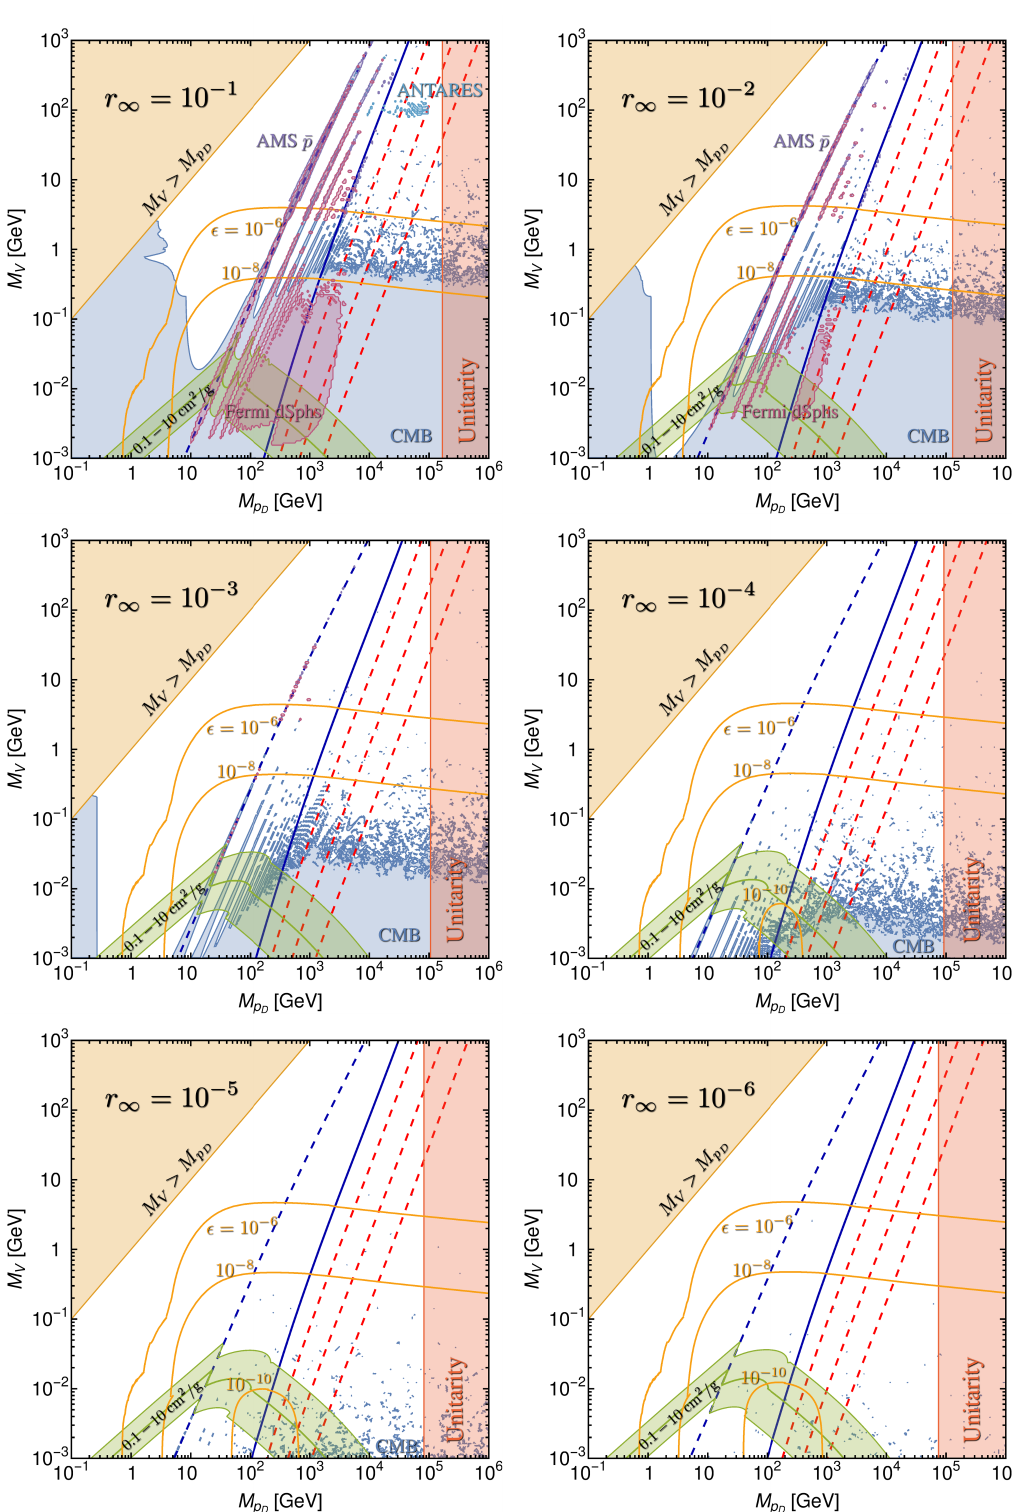
Figure 4: Same as for Fig. 1, but with decreasing values of the fractional antiparticle population, r ∞ . The indirect detection constraints still apply for moderate values of r ∞ , but the green shaded area (where sizable self-interactions are possible) eventu- ally